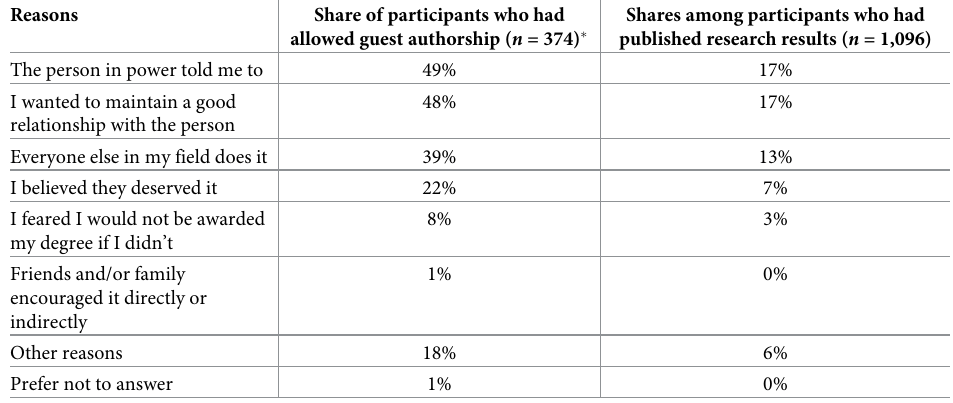
Table 8. For participants who had granted a guest authorship to a person in power at least once: “Which of the following best describes your reason for doing so?”. Reasons Share of participants who had Shares among participants who had published research results ( n = 1,096) allowed guest authorship ( n = 374) � The person in power told me to